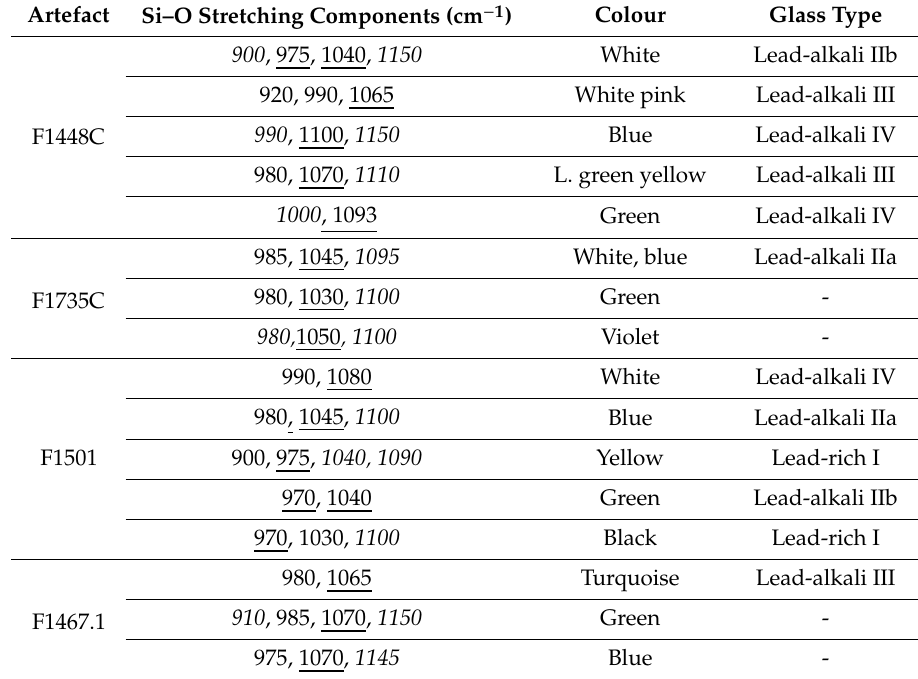
Table 3. SiO 4 stretching components of the cloisonn é enamels analysed (strongest; shoulder ).